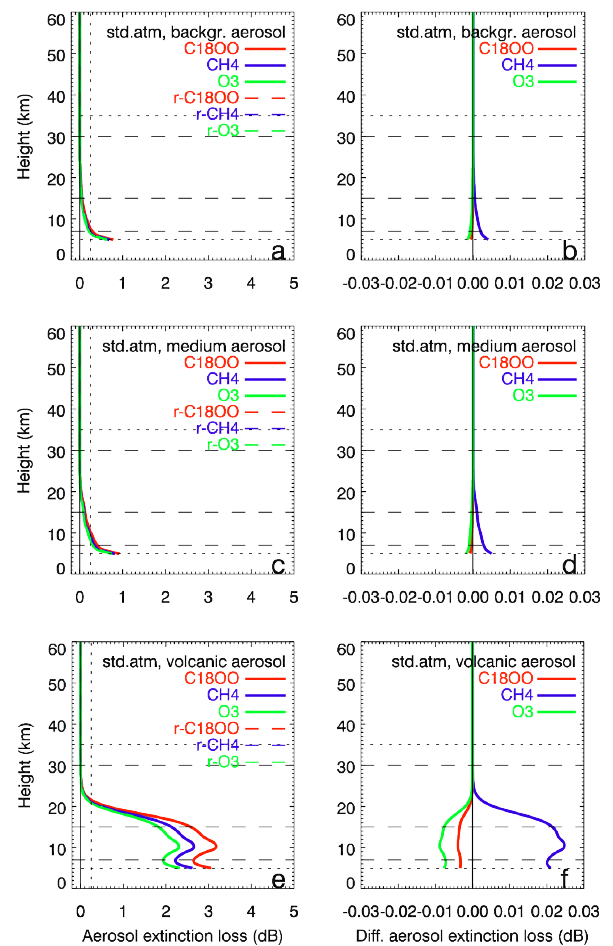
Fig. 7. Aerosol extinction loss (a, c, e) and differential aerosol extinction loss (b, d, f) for three representative channel pairs with different spectral separation under FASCODE STD atmosphere conditions for background (a, b) , medium (c, d) , and volcanic (e, f) aerosol load. The vertical dotted line marks the boundary where the extinction loss, if transgressing it, enters into the favourable range for target species loss. The horizontal dotted and dashed lines mark target and threshold requirements, respectively, regarding the vertical range within which trace species shall be retrieved.